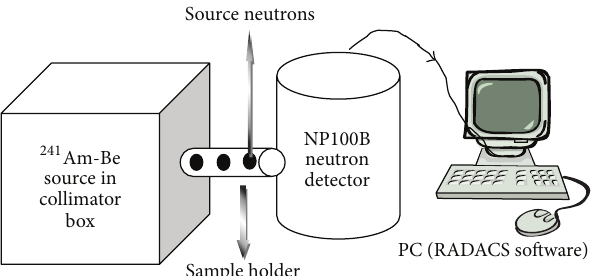
Figure 2: Experimental arrangement.